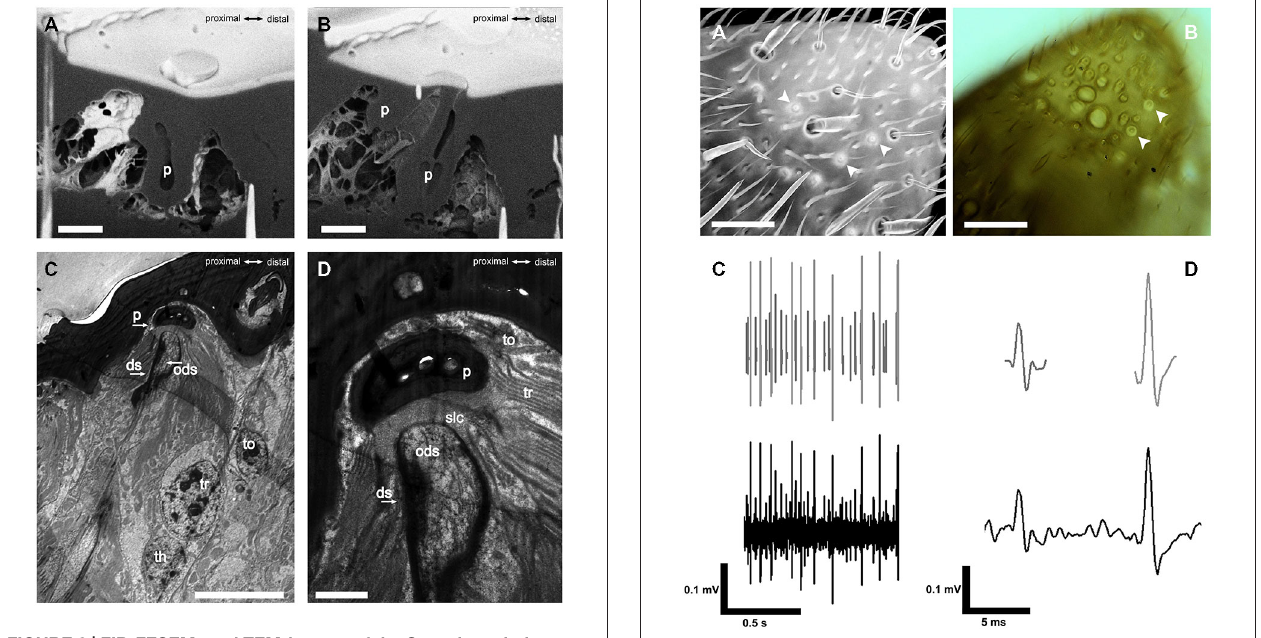
FIGURE 3 | Identification of the S. coelocapitulum and extracellular recordings of the associated sensory neurons. (A) Projection-view of the antennal tip after confocal laser scanning microscopic investigation. The autofluorescence of the cuticle was used to identify the S. coelocapitula on the distal, ventral-lateral side of the antenna. The cuticular pit and cuticular-dense mushroom-like protrusion of the S. coelocapitulum is indicated by a higher autofluorescence signal (arrowheads). (B) Transmission light microscopy of the S. coelocapitulum. The mushroom-like protrusion and the cuticular pit below the antennal surface cause different light refraction. The circular structure with a central cuticular protrusion shows no extruding hair structure when focused through different levels (arrowheads). (C,D) Extracellular recording (bottom line) of the sensory neurons associated with the S. coelocapitulum. The neuronal signals of two different sensory neurons can be distinguished after spike sorting and template matching (upper